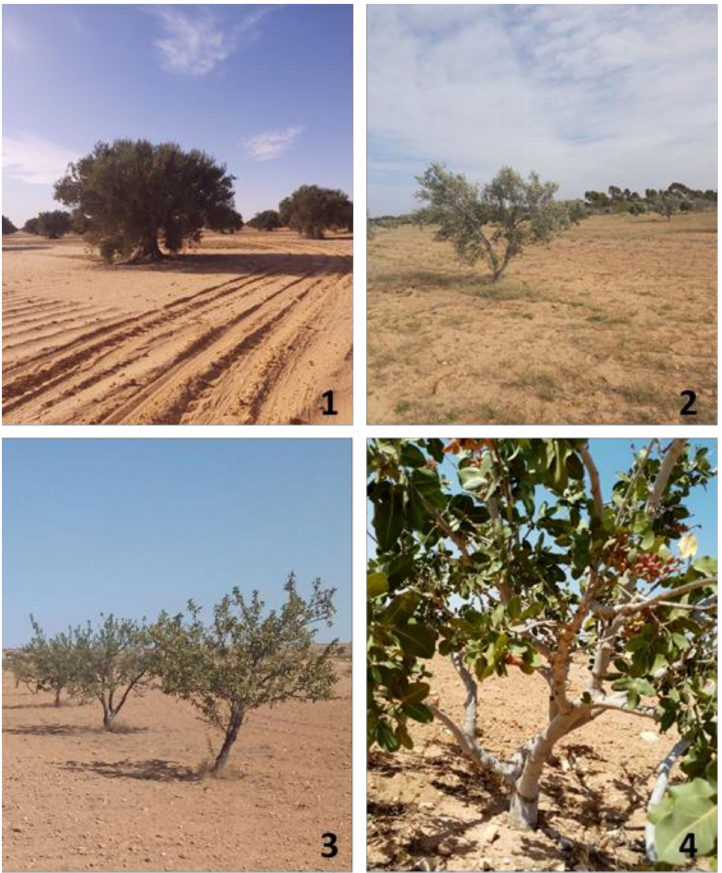
Figure 2. Different land uses in the experimental farm: Centenary olive grove, young olive grove, almond tree, and pistachio tree. ( 1 ): Centenary olive grove—old cultivated > 100 years; ( 2 ): young olive grove—newly cultivated < 12 years; ( 3 ): almond tree—newly cultivated < 12 years; ( 4 ): pistachio tree—newly cultivated < 12